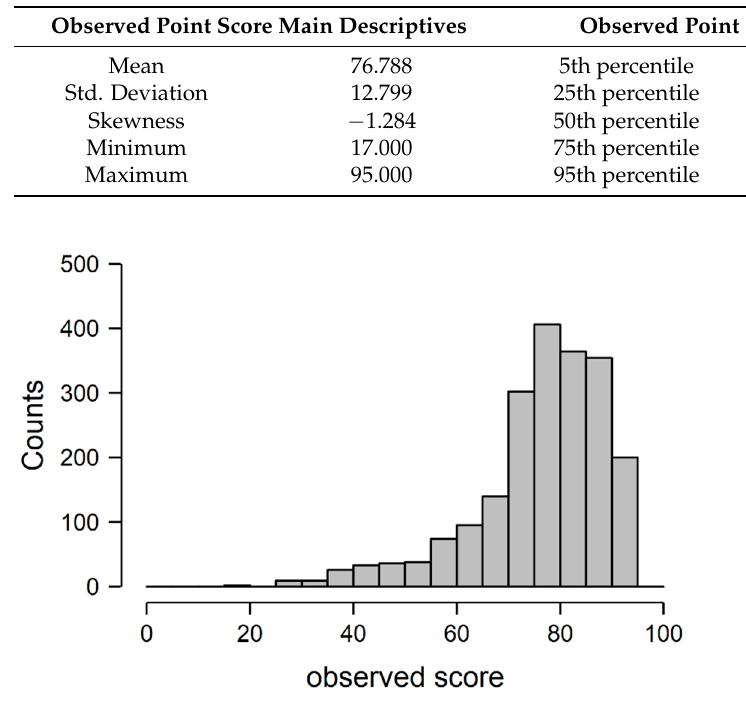
Table 4. Observed point score.